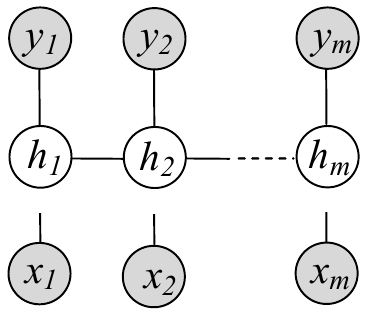
Figure 6. LDCRF model, in which x j is to the value of j th the corresponding observation, the hidden state of x j is to h j . y j represents a label of x j , such that the gray circle is to the observation